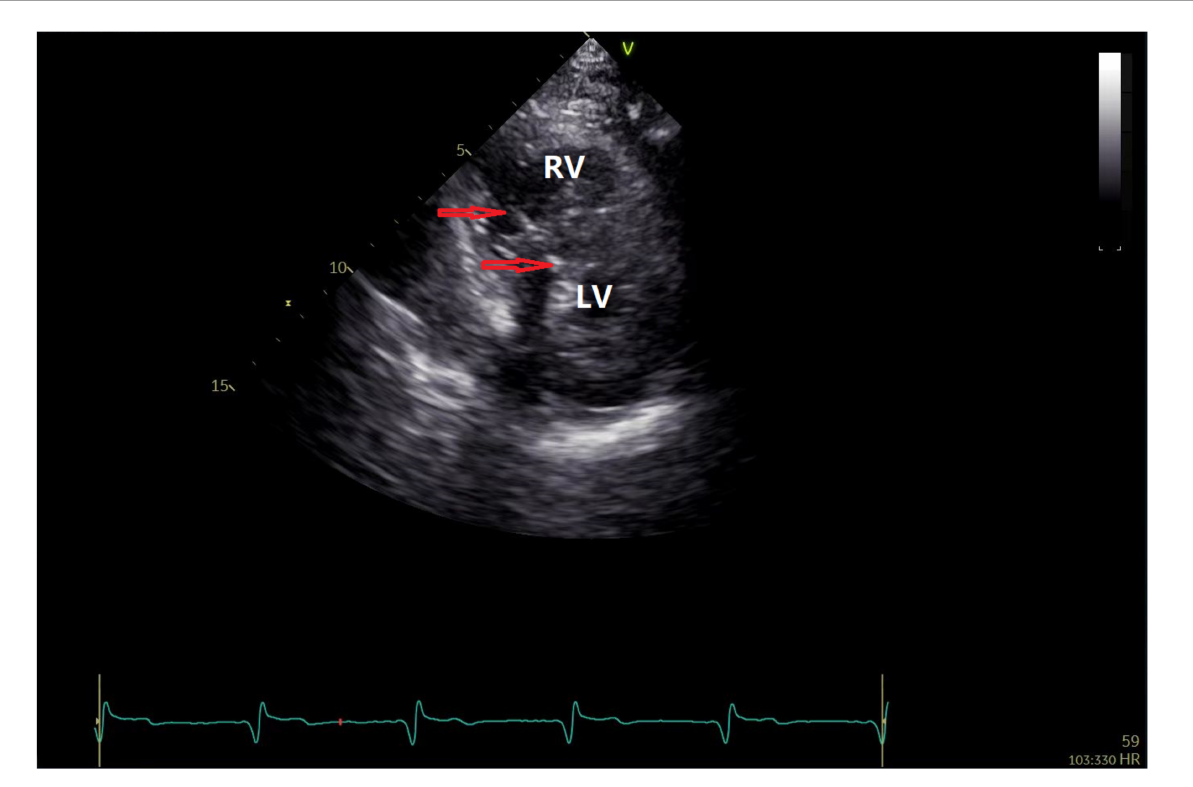
FIGURE1 Echocardiography to position the HPSAP electrode. The red arrow indicates that the end of the pacemaker electrode is located below the endocardium of the left ventricle.